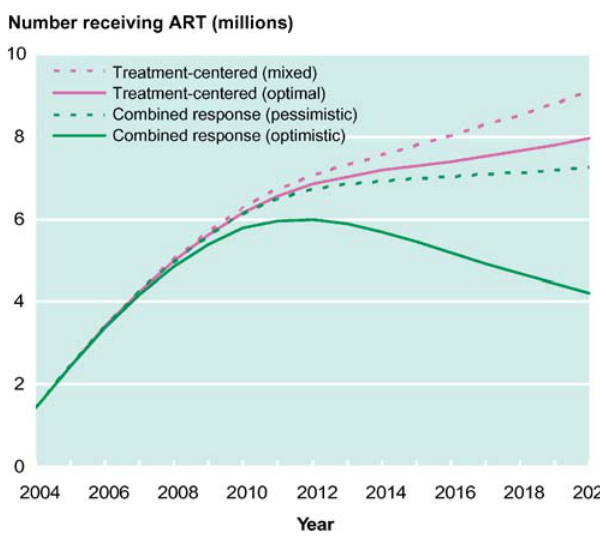
Figure 2. Number of Persons on ART in Sub-Saharan Africa, 2004–2020, under Various Scenarios DOI: 10.1371/journal.pmed.0020016.g002 PLoS Medicine |